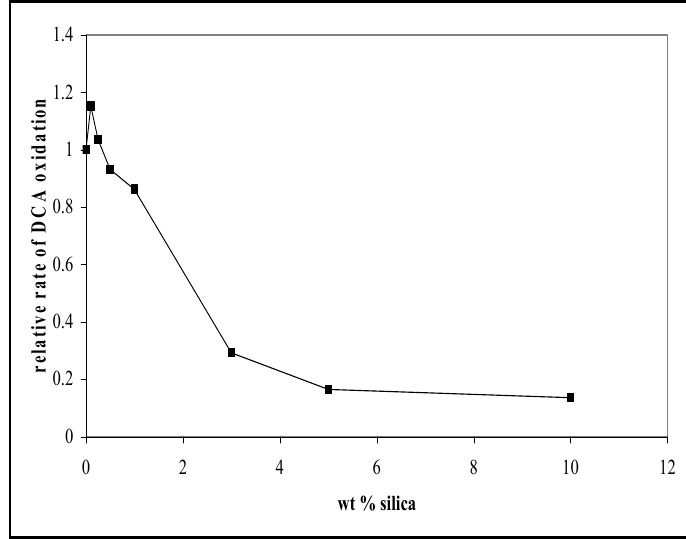
Figure 8. Decrease in relative rates of dichloracetate oxidation at high levels of silica deposited on rutile #2. (The activity of rutile #2 is taken as